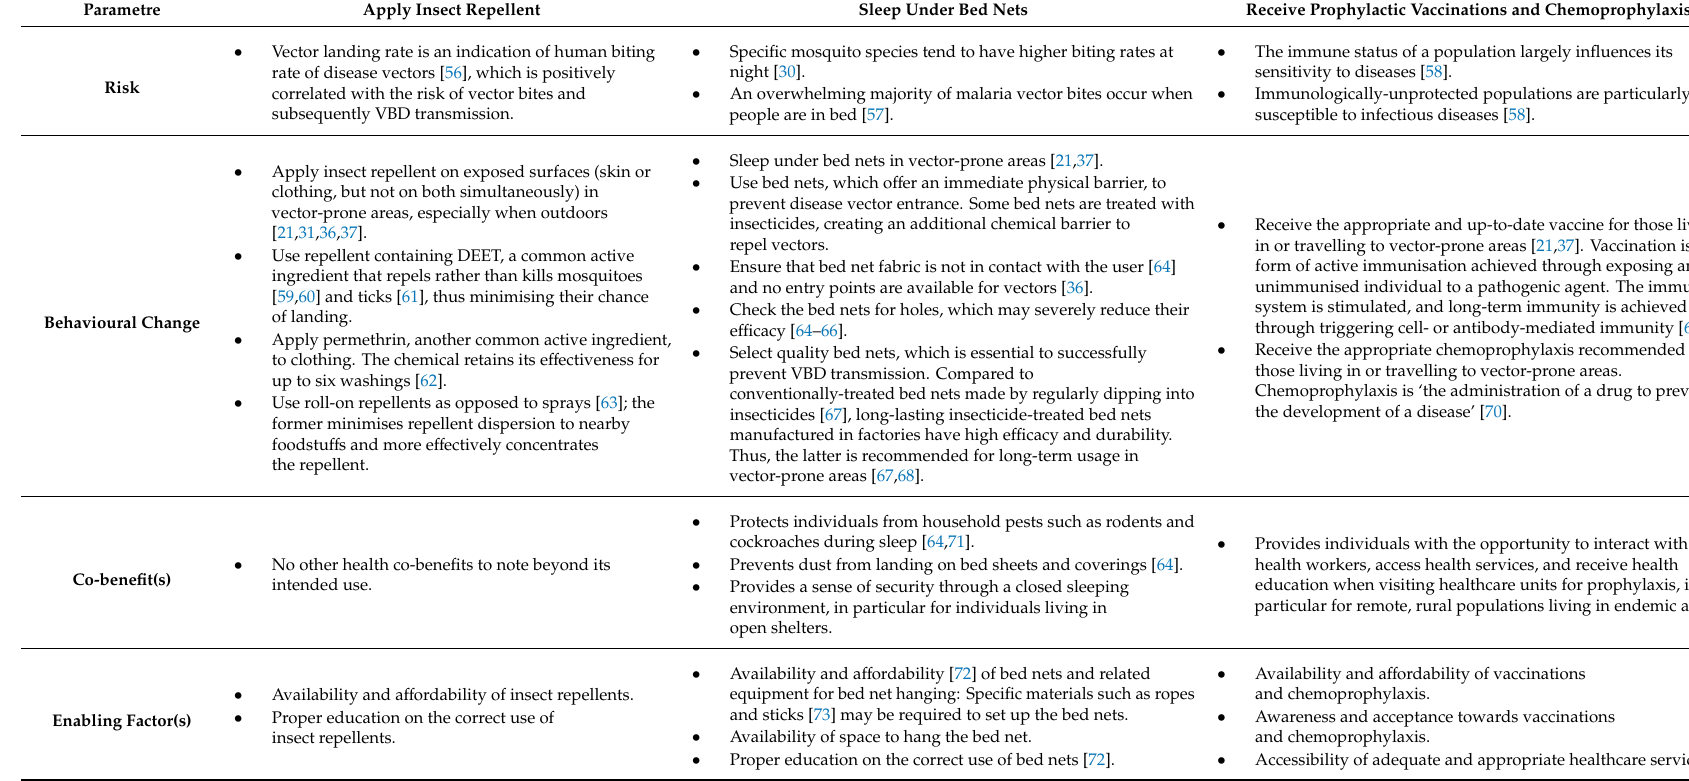
Table 2. Personal Protection Practices as Health-EDRM Primary Prevention Approaches against VBDs (Part 2).